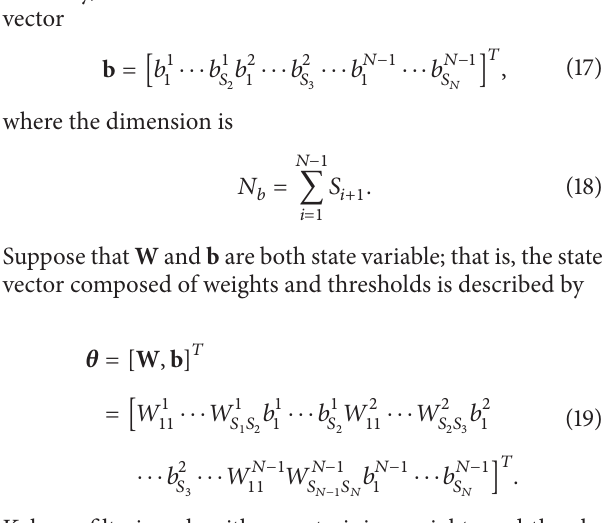
Kalman filtering algorithm on training weights and